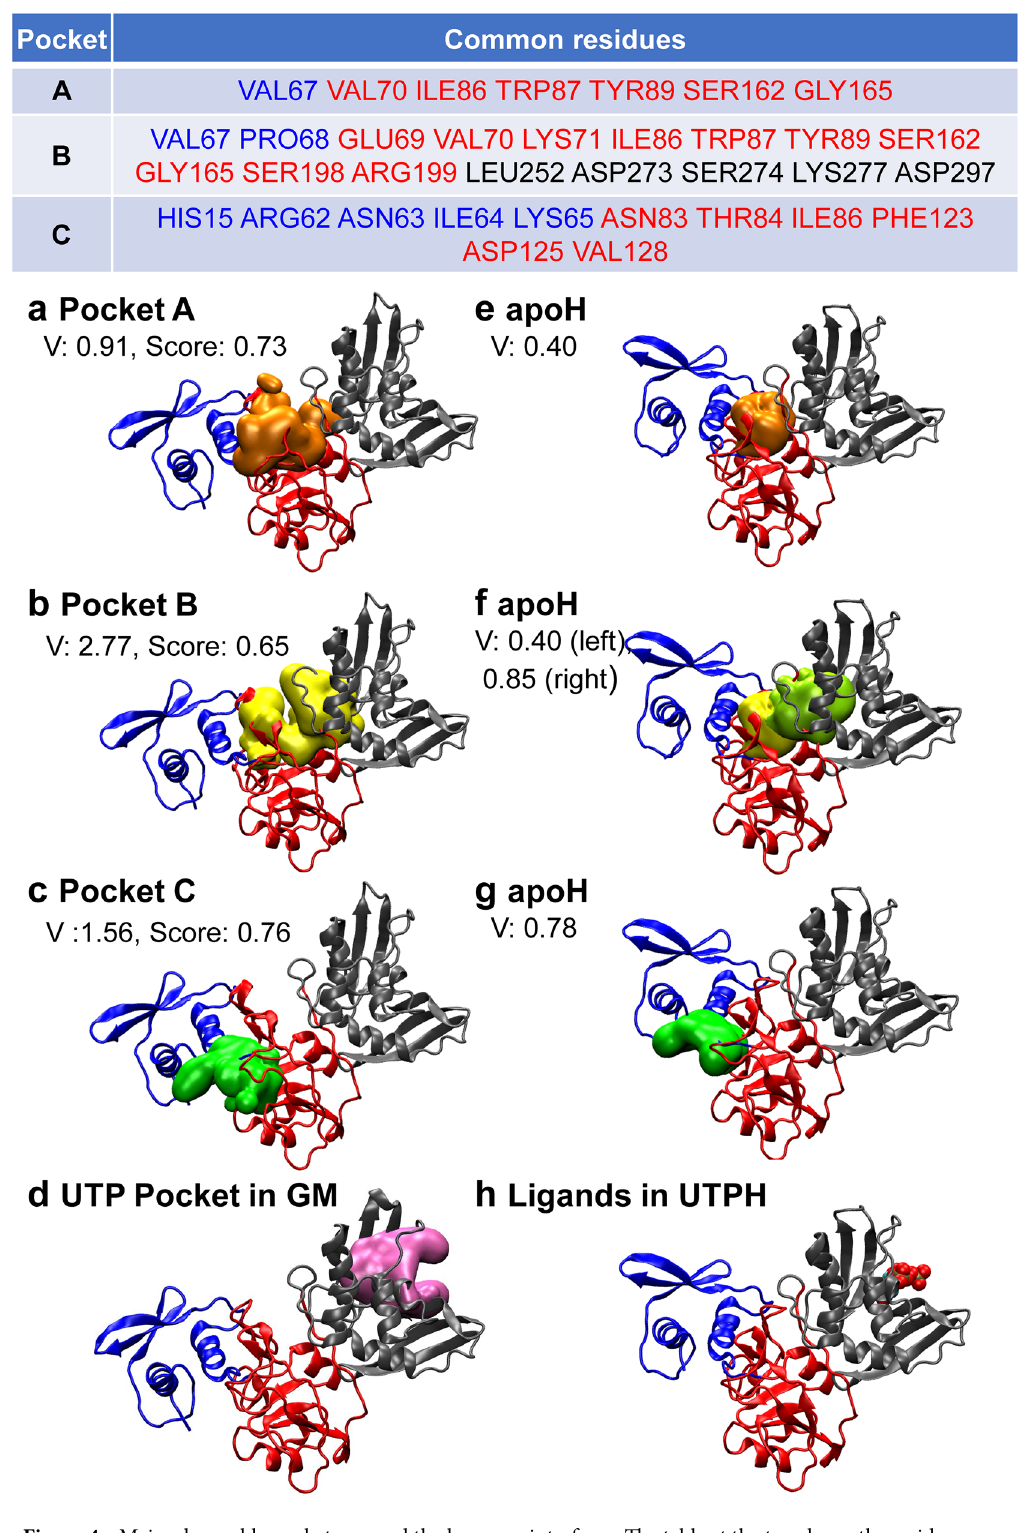
Figure 4. Major druggable pockets around the hexamer interfaces. The table at the top shows the residues common to the pockets and are assigned as Pockets A ‒ C. The residue names shown in blue, red, and black indicate that they belong to N-term, Mid, or C-term domain, respectively. ( a) Pockets A (green), ( b ) B (yellow), and ( c ) C (orange) identified for the monomer GM conformation. Druggable score of the pocket (Score) and pocket volume (V. unit: nm 3 ) are shown. ( d ) UTP-binding pocket found in GM. ( e ‒ g ) The pockets most overlapped with pockets A ‒ C in apoH are depicted. ( h ) UTPH structure and 5 ′ -UMP shown as a CPK model. Each domain is specified by a distinct color, as in Fig.